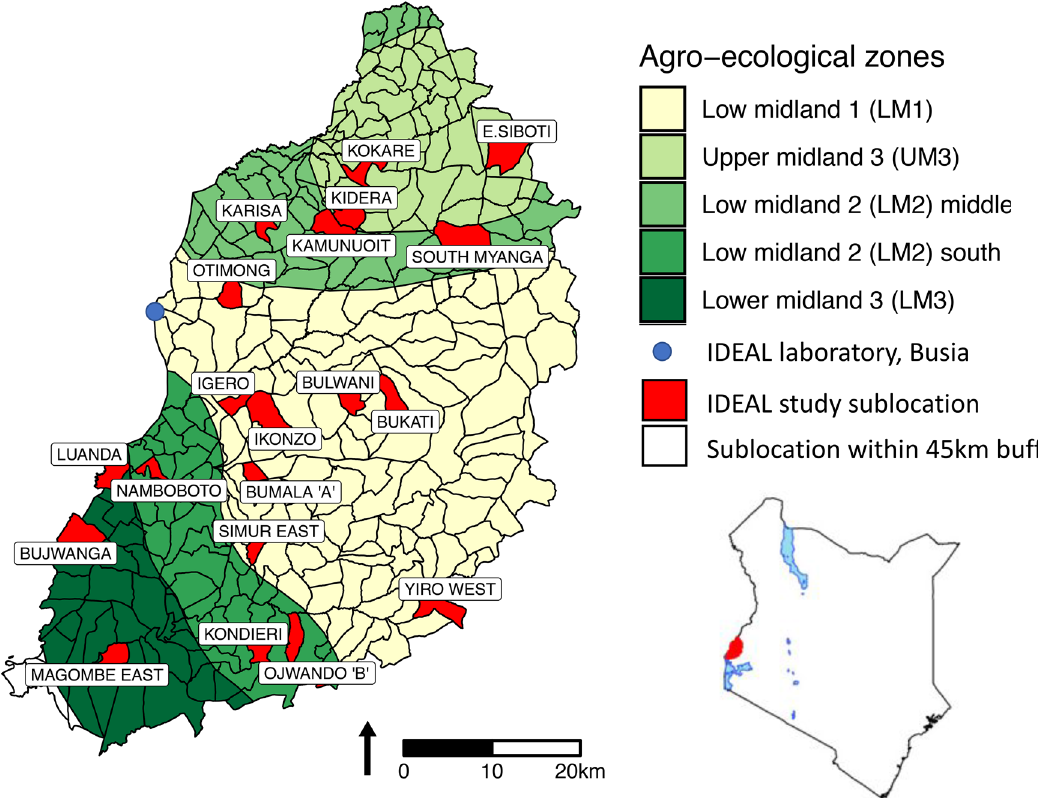
Figure 1. Map of western Kenya showing the study area, agro-ecological zones and sublocations. Selected sublocations are highlighted in red. Figure taken from Bronsvoort et al.